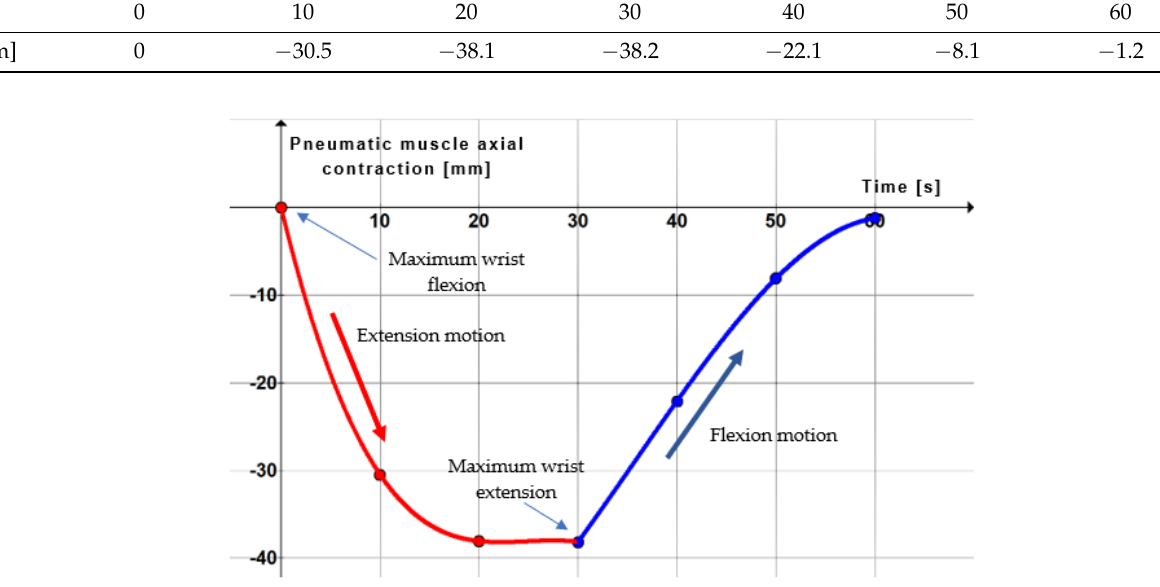
Figure 16. Variation versus time of the pneumatic muscle axial contraction. The dots represent the measured values of the axial contractions, and the continuous lines show the polynomial regression curves suggested by Graph v. 4.4.2 software.